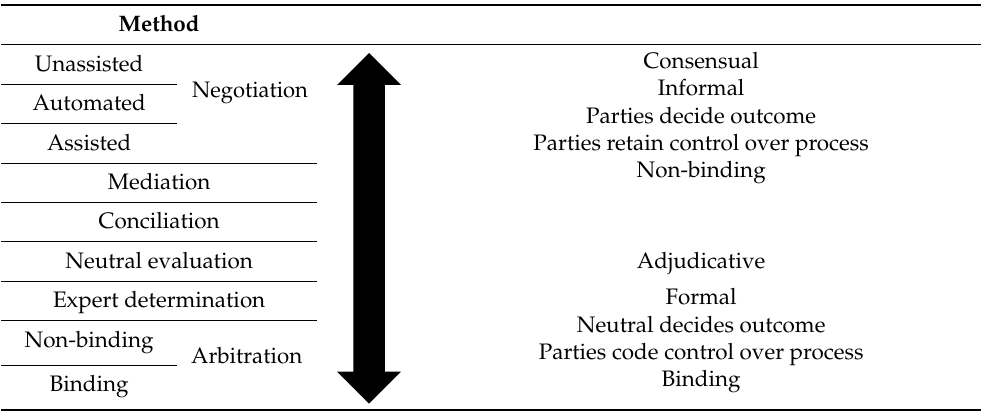
Table 1. Types of ODR.